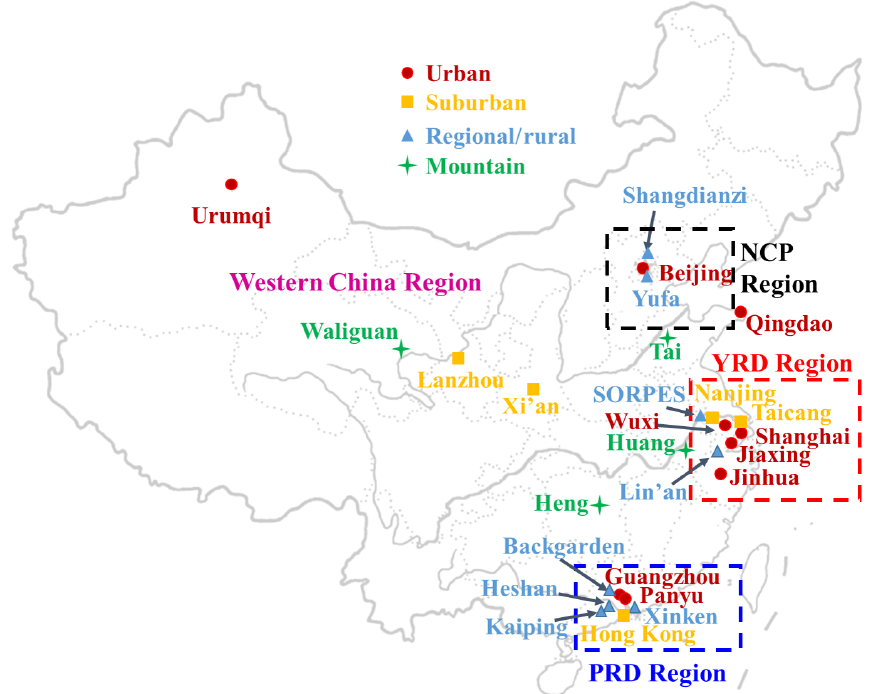
Figure 1. Map of observation sites involving NPF study in China. Most of these observations sites were classified into four regions in this study, i.e. North China Plain (NCP), Yangtze River delta (YRD), Pearl River delta (PRD) and western China region